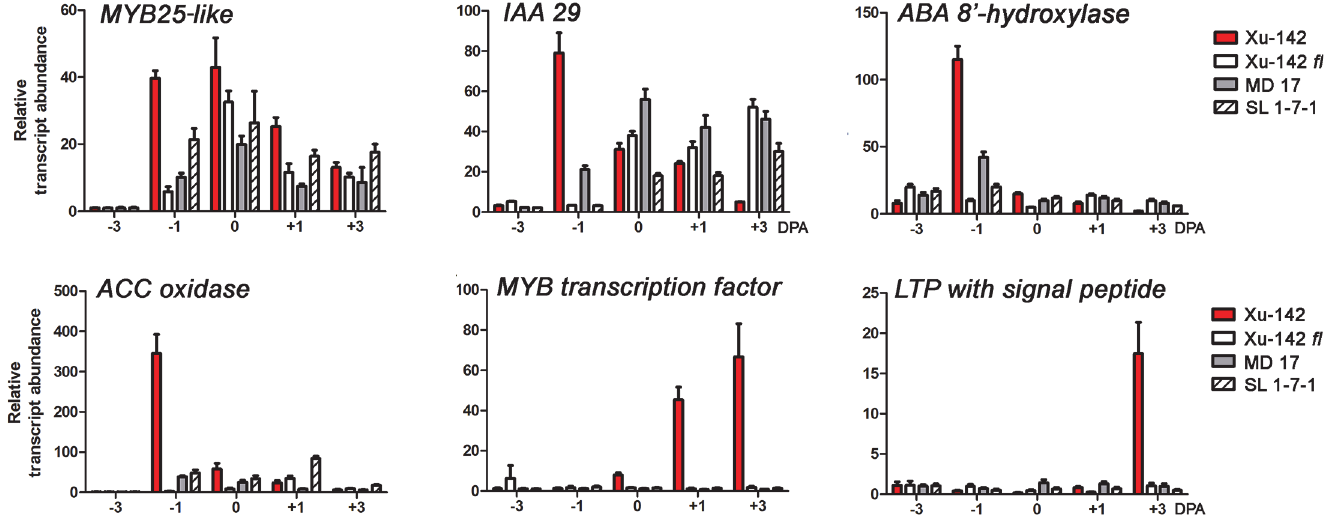
Fig 6. Expression patterns of Class 1 DEGs, genes more highly expressed in wild type ovules than the fiberless mutant ovules. Transcript levels were measured by RT-qPCR from a WT (Xu-142) and three fiberless mutants (Xu-142 fl , MD 17, and SL 1-7-1) that were harvested on -3, -1, 0, 1, and 3 DPA. MYB25-like (Gorai.008G179600), IAA 29 (Gorai.001G043900)), ABA 8'-hydroylase (Gorai.004G177200), ACC oxidase (Gorai.001G011100), MYB transcription factor (Gorai.013G196800), LTP with a signal peptide (Gorai.008G057100). All RT-qPCR analyses were performed with three biological replications at each time point with five technical replications. The error bars represent the SD.